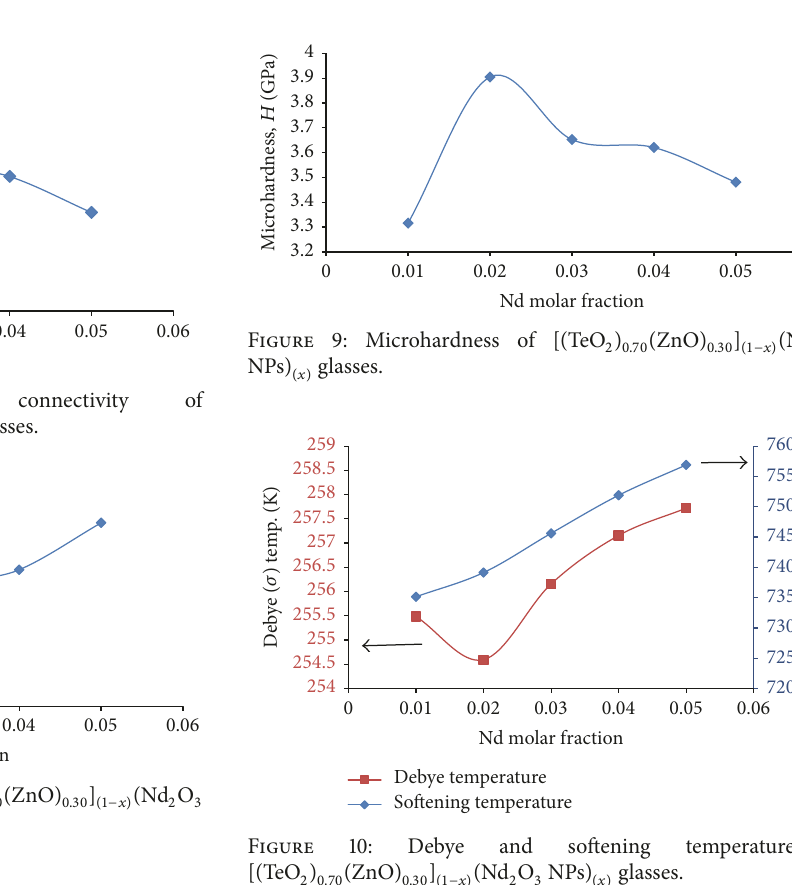
Figure 10: Debye and softening temperature of [(TeO 2 ) 0.70 (ZnO) 0.30 ] (1−𝑥) (Nd 2 O 3 NPs) (𝑥)